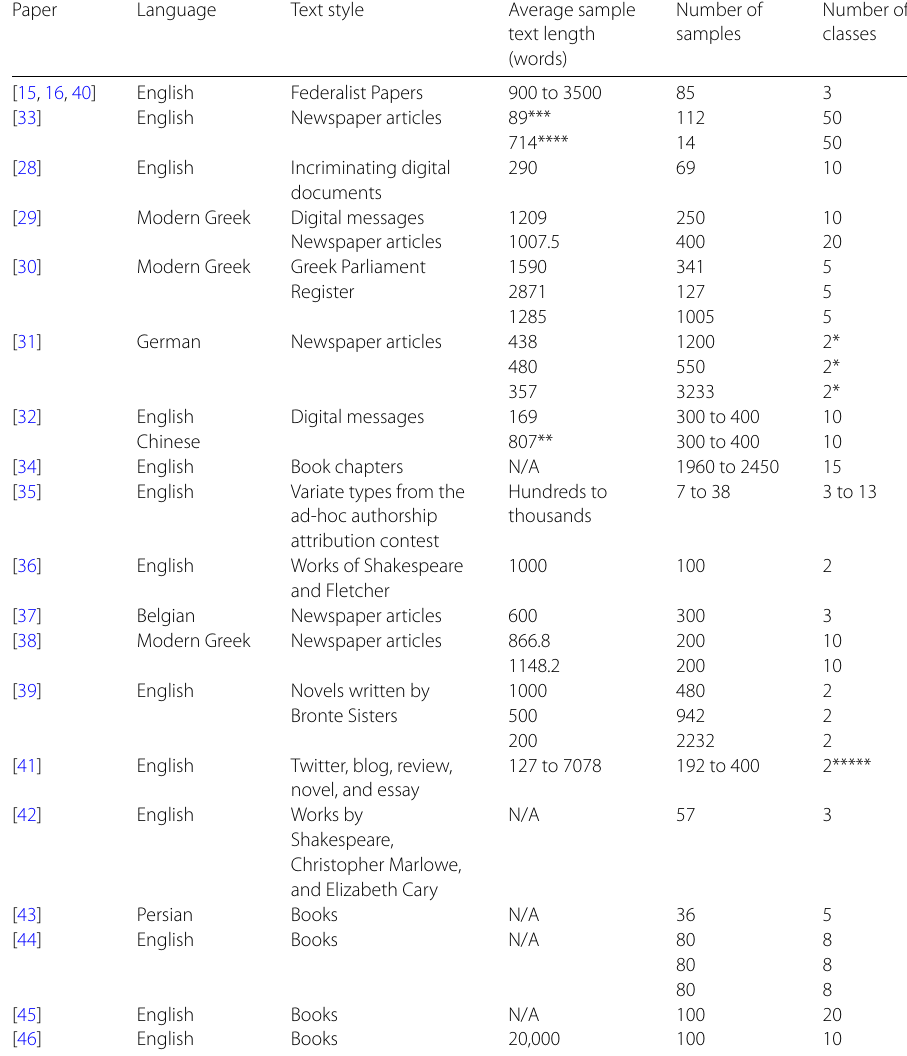
Table 1 Overview of representative authorship attribution problems. References [15, 28–39] discuss vector space models